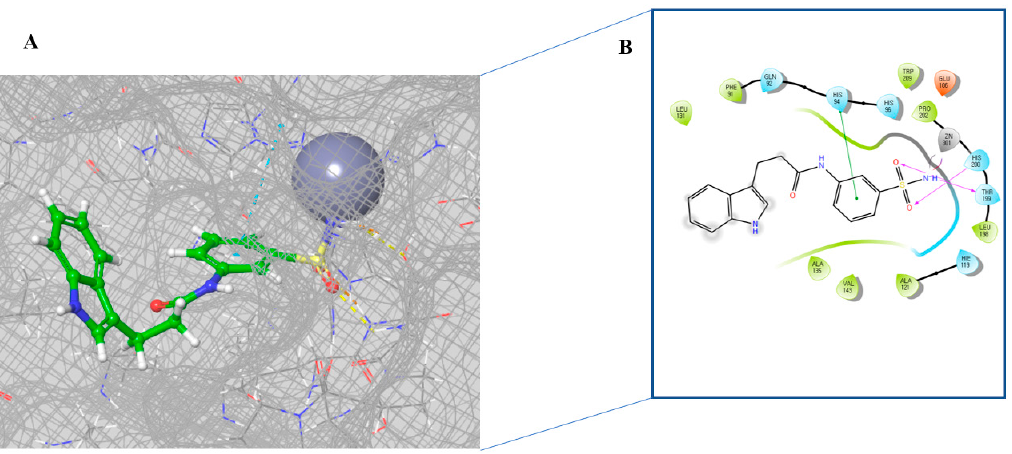
Figure 4. The interaction patterns of compound 2a in the active sites of hCAI. ( A ) 3D model of compound 2a surface CA active site, with the surface viewed in the mesh format. ( B ) 2D interaction pattern of compound 2a with hCA I active site.